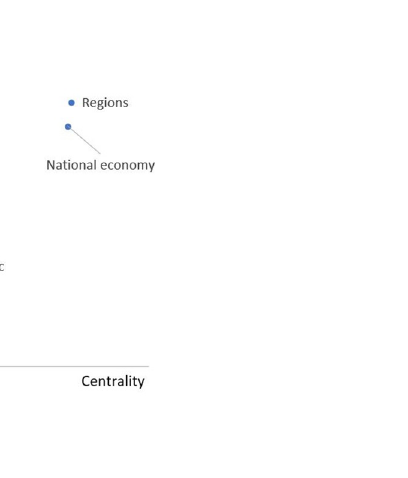
Fig 8. Strategic diagram between 2013 and